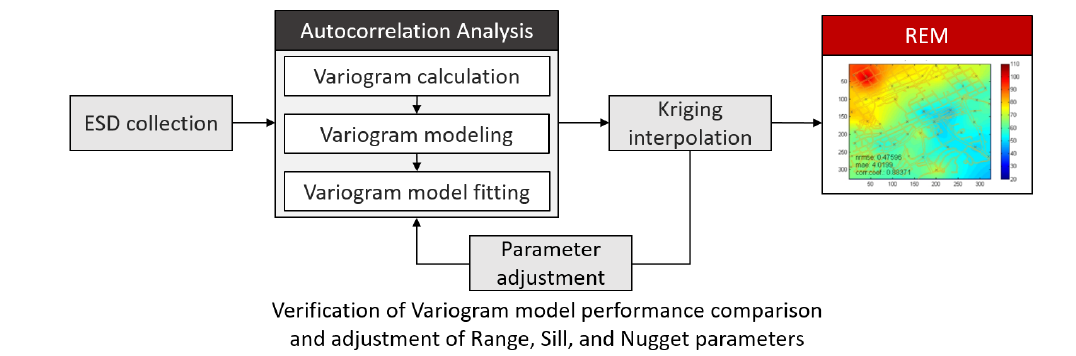
Figure 3. Block diagram of the Kriging interpolation process for the